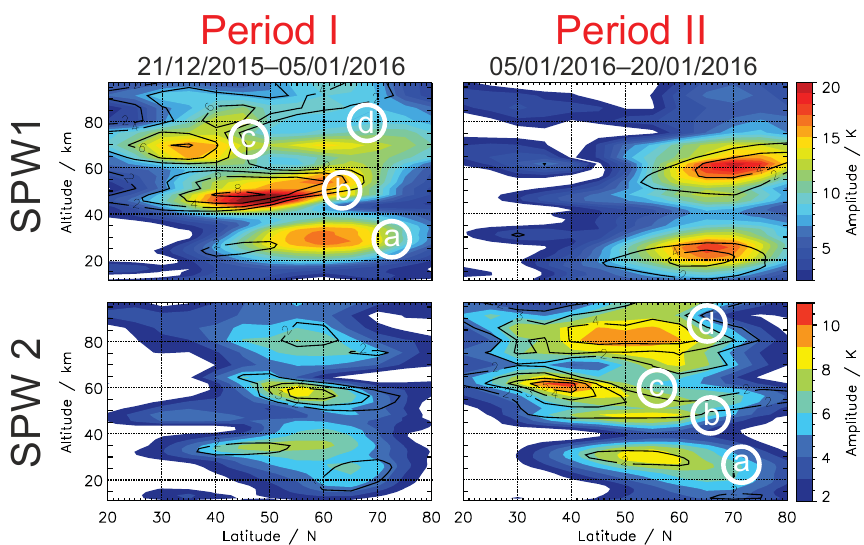
Figure 1. Latitude–altitude cross sections of the SPW 1 and 2 derived from MLS temperature data. The amplitude as it occurred in the Arctic winter 2015/2016 is color coded, the deviation from the 12-year mean is presented by contour lines for the respective time period from MLS temperature data. The first half of the time period investigated here is hereafter referred to as Period I and the second half Period